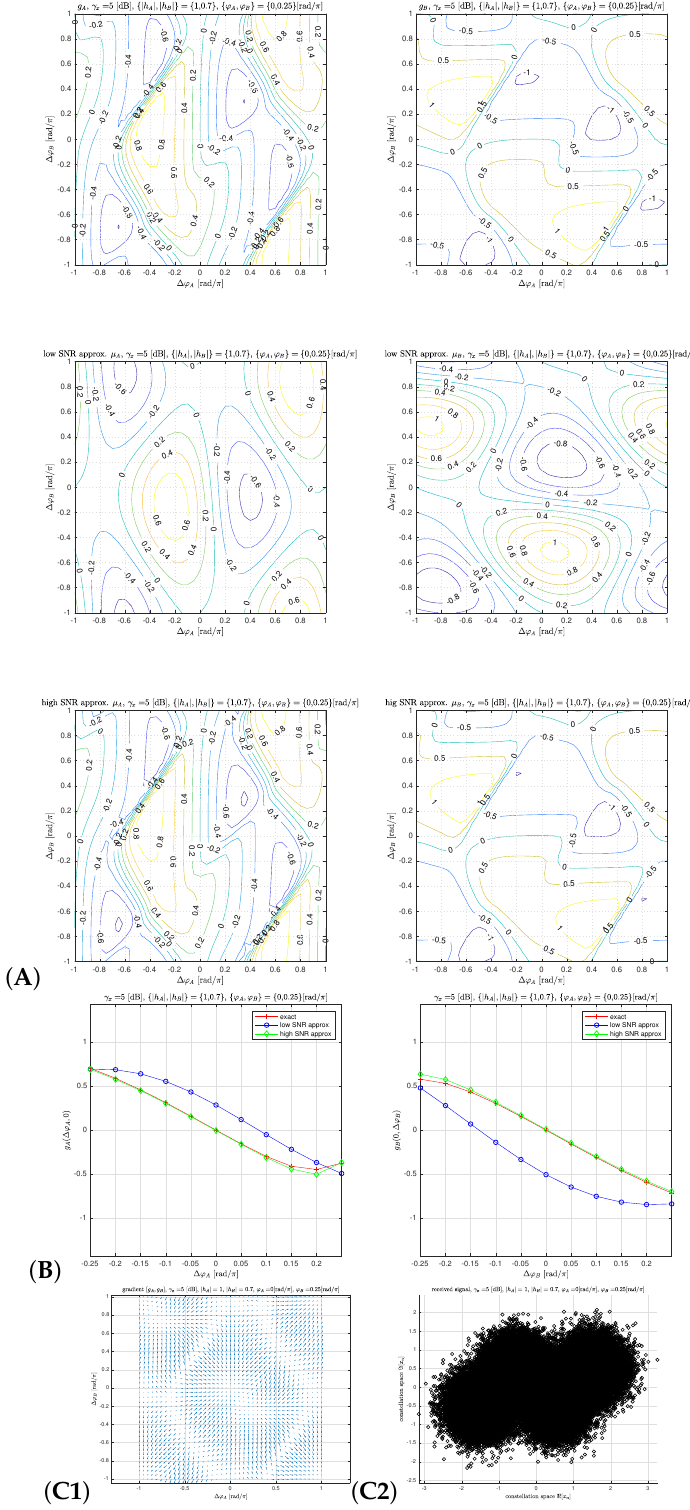
Figure 2. Equivalent detector characteristics for γ x = 5 dB, h A = 1e j0 , h B = 0.7e j0.25 π . ( A ) detector components g A ( ∆ ϕ ) , g B ( ∆ ϕ ) (row #1) exact , (row #2) low SNR approximation, (row #3) high SNR approximation; ( B ) detector components g A ( ∆ ϕ A ,0 ) , g B ( 0, ∆ ϕ B ) ; ( C1 ) gradient directions (exact); ( C2 ) random received constellation